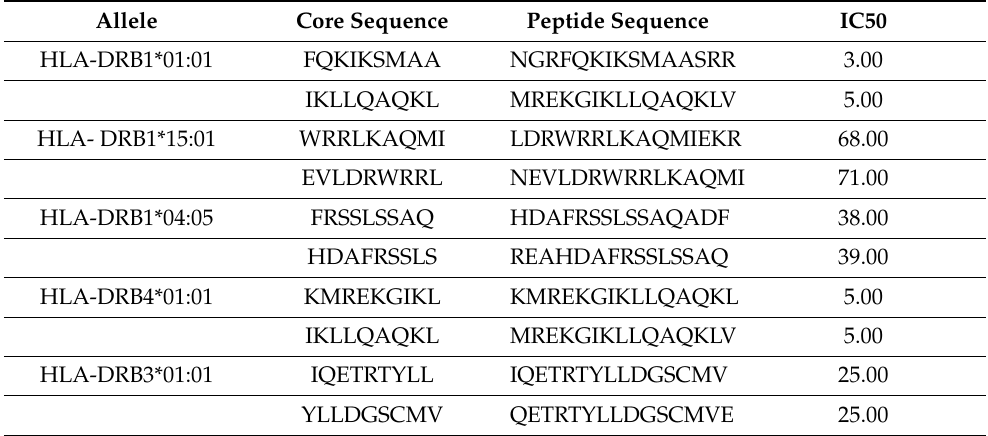
Table 13. Predicted peptides on risk alleles for human α